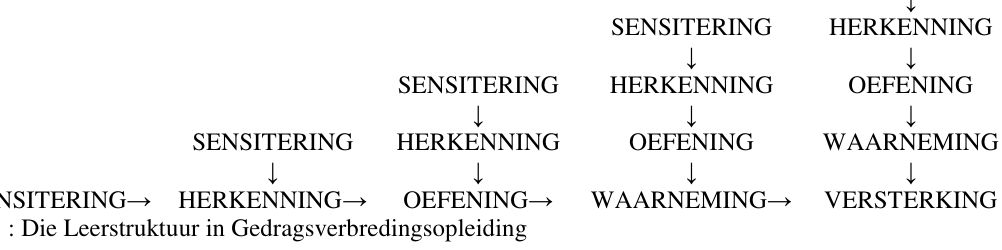
Figuur 1 : Die Leerstruktuur in Gedragsverbredingsopleiding Op hierdie wyse is daar as eerste step operasionele gestalte gegee aan gedrags- verbreding as opleidingstegnologie. Die volgende stap in die operasionalisering van gedragsverbreding was om 'n opleidingskursus volgens gedragsverbredingstegnologie te ontwikkel en dit dan eksperimenteel te toets. Dit sou dan die finale bewysplaas wees